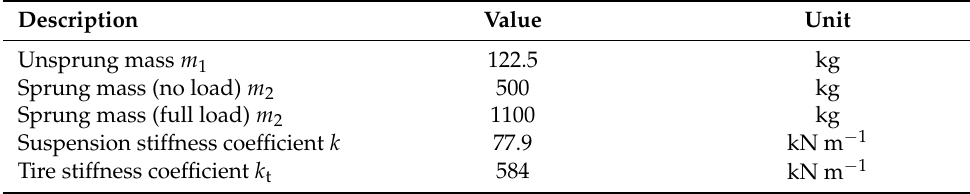
Table 5. Model parameters of the quarter